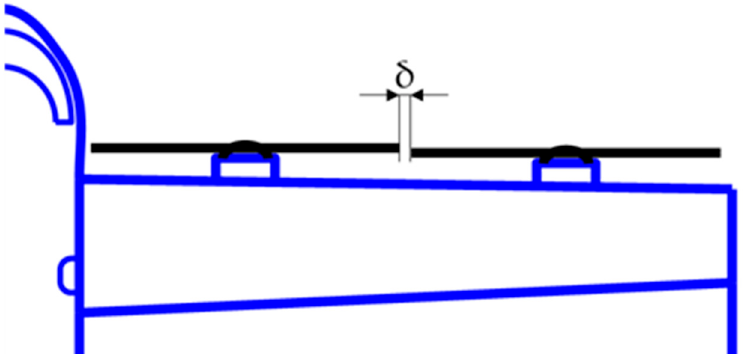
Table 9. Main constraints for the box-wing tilt-wing conceptual design. MTOW <3175 kg, according to [32] Wingspan <13 m, according to [38] Clearance between propellers >0.1 m The clearance between propellers has been evaluated according to Equation (19).